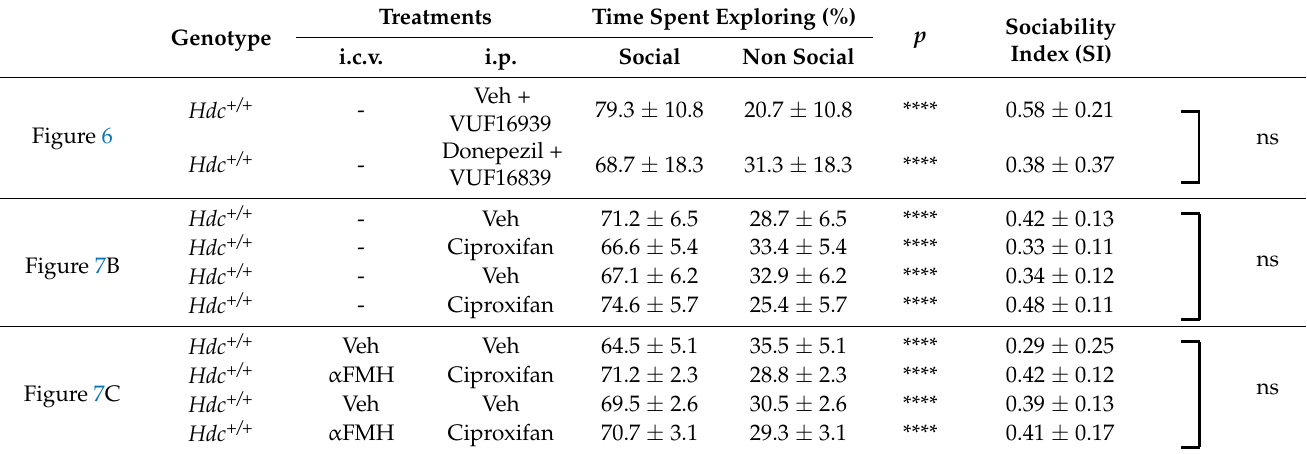
Social preference is assessed by the difference in the percentage of time spent exploring the cup containing a conspecific juvenile (social) versus the empty cup (non-social). Sociability index (SI) was calculated as described in Material and Methods. All the re- sults are reported as mean ± SD of 6–10 animals per experimental group (*** p < 0.001; **** p < 0.0001 by Two Way ANOVA and Bonferroni’s MCT).